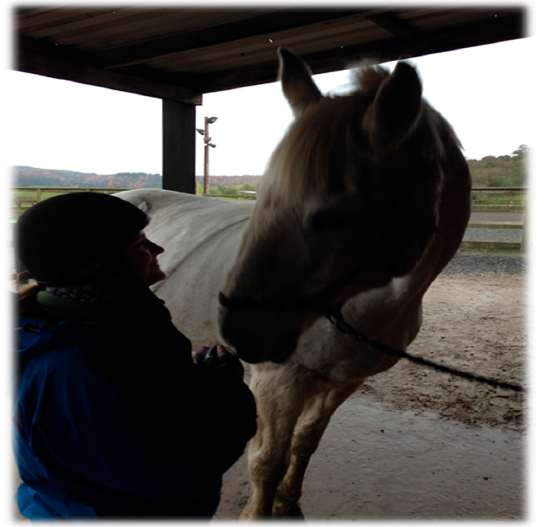
Figure 5. Human-horse “mirroring” and relating.